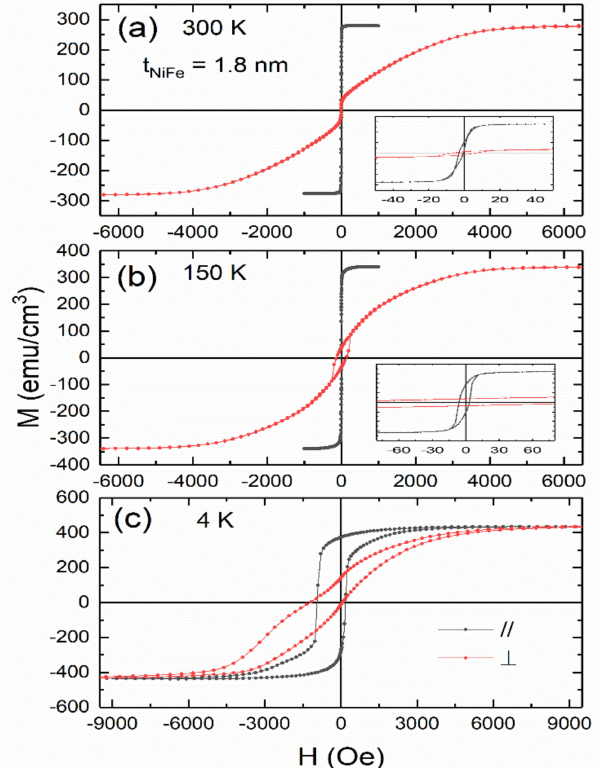
Figure 9. Temperature-dependent magnetization hysteresis loops with the external field applied perpendicular (red circles) and parallel (black circles) to the film plane for a NiFe/NiFeO multilayer with t NiFe = 1.8 nm and 13 repetitions for 300 K ( a ), 150 K ( b ) and 4 K ( c ). The inset in Figure 9 is a magnified plot near-zero field for better clarity.